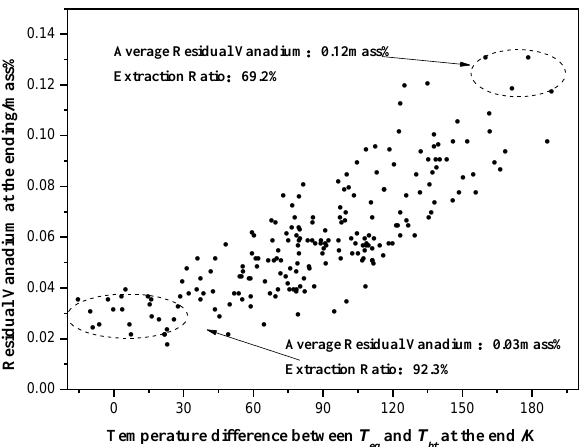
Figure 6. Relationship between the residual vanadium and Δ T at the final.